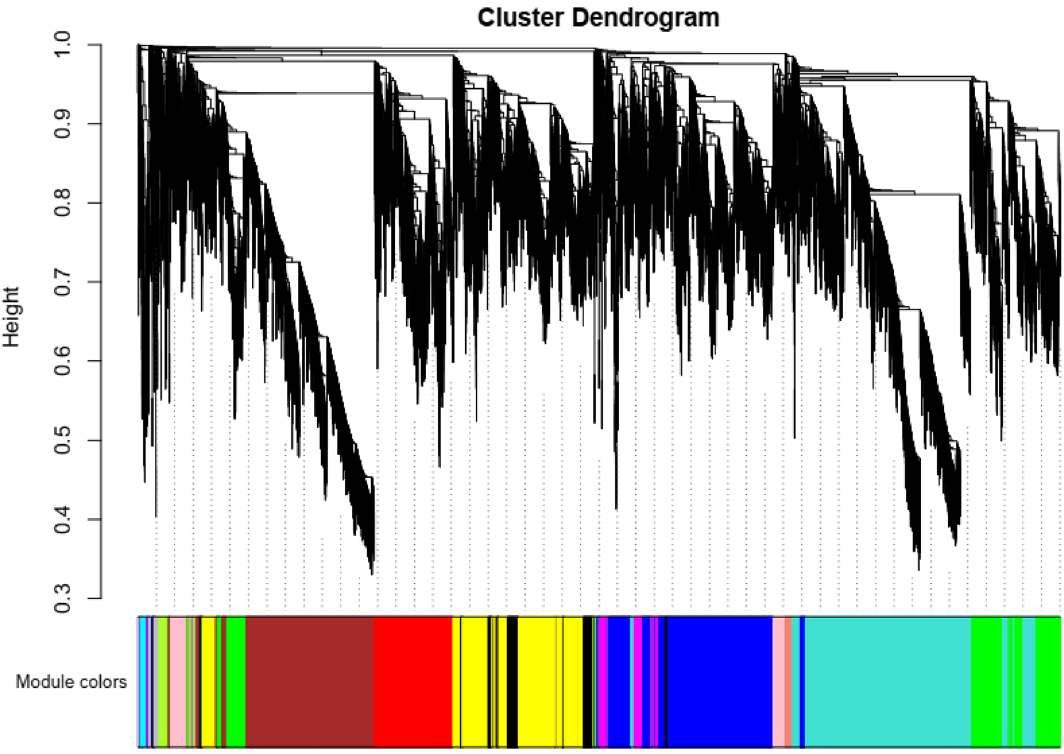
Figure 6. Weighted gene correlation network analysis (WGCNA). Hierarchical clustering of the topological overlap matrix for V. dahliae expression data.